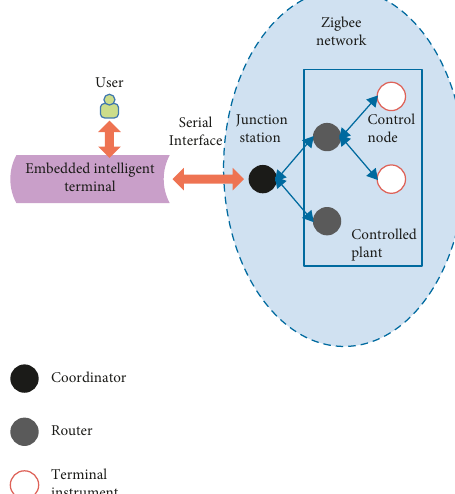
Figure 5: Vector pie chart.